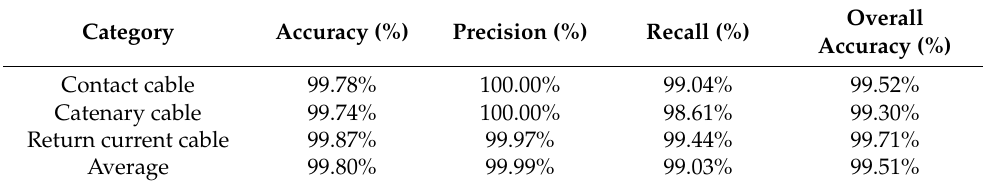
Table 5. Accuracy evaluation index for the 50 m OCS point cloud classification results by Terrasolid.